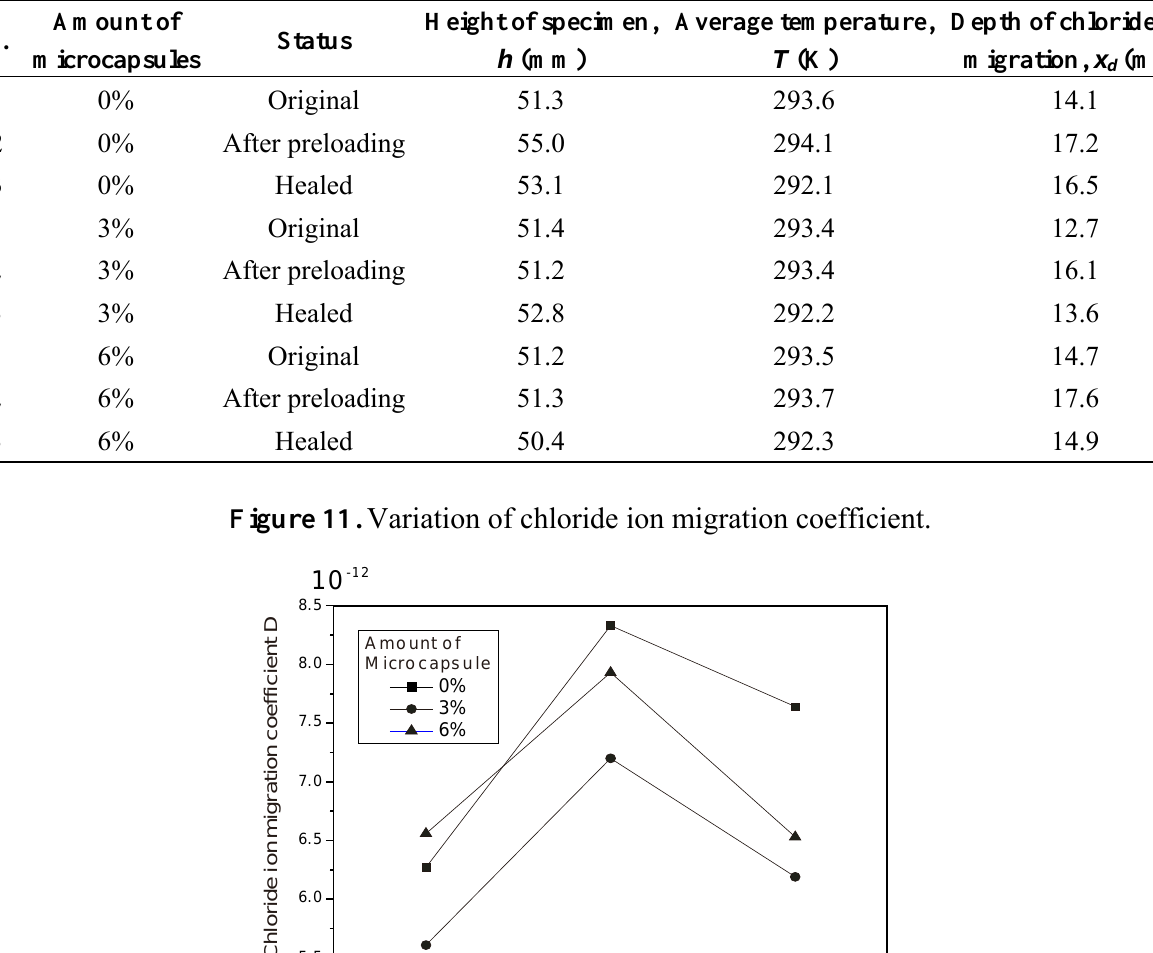
Table 4. RCM test results.